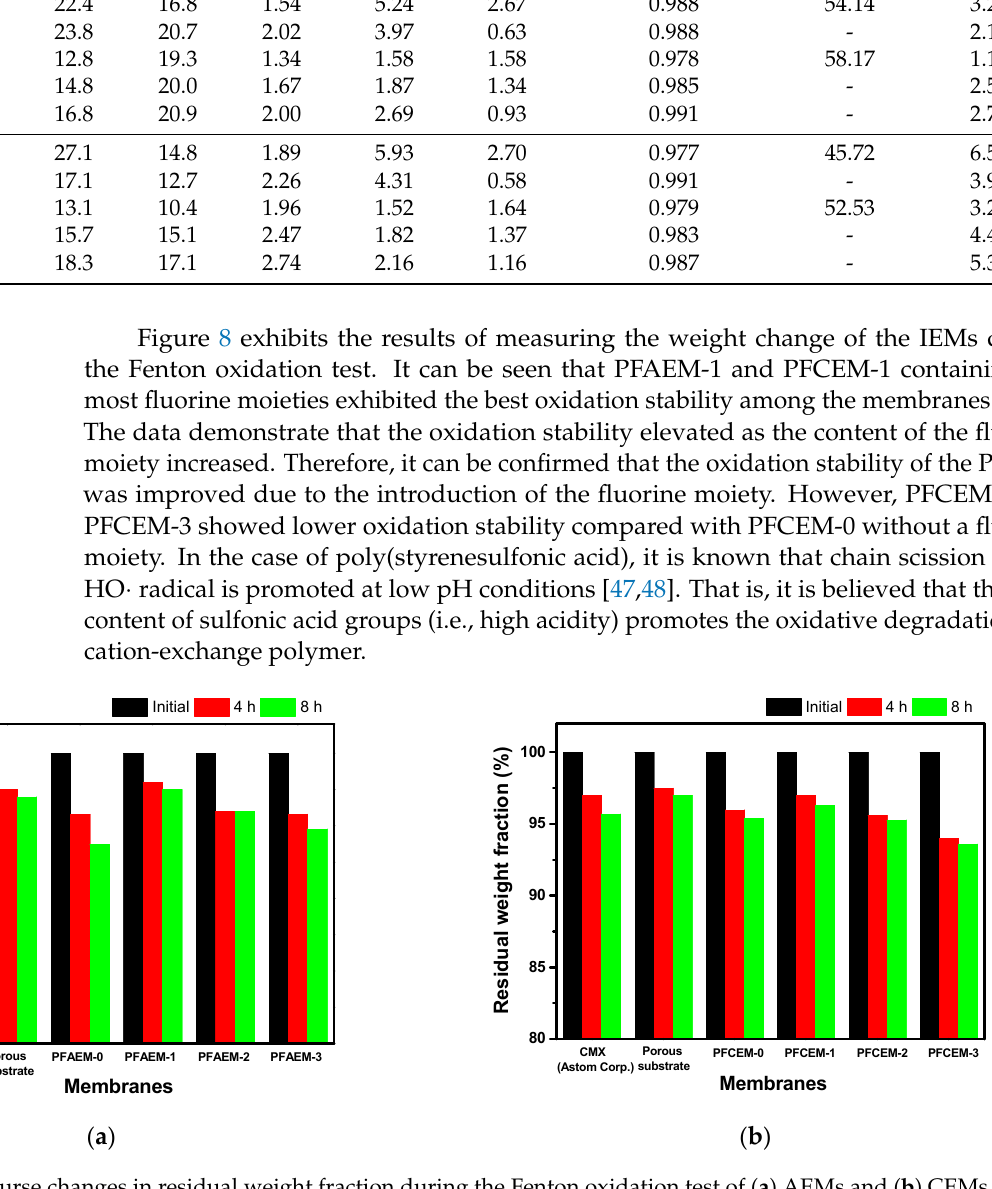
Table 5. Various properties of commercial membranes and PFIEMs.